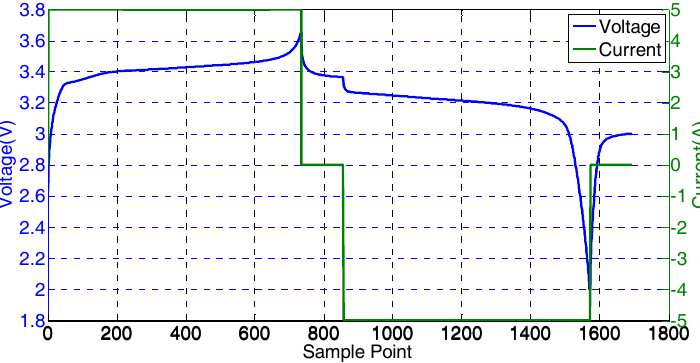
Figure 1. Battery test schedule.